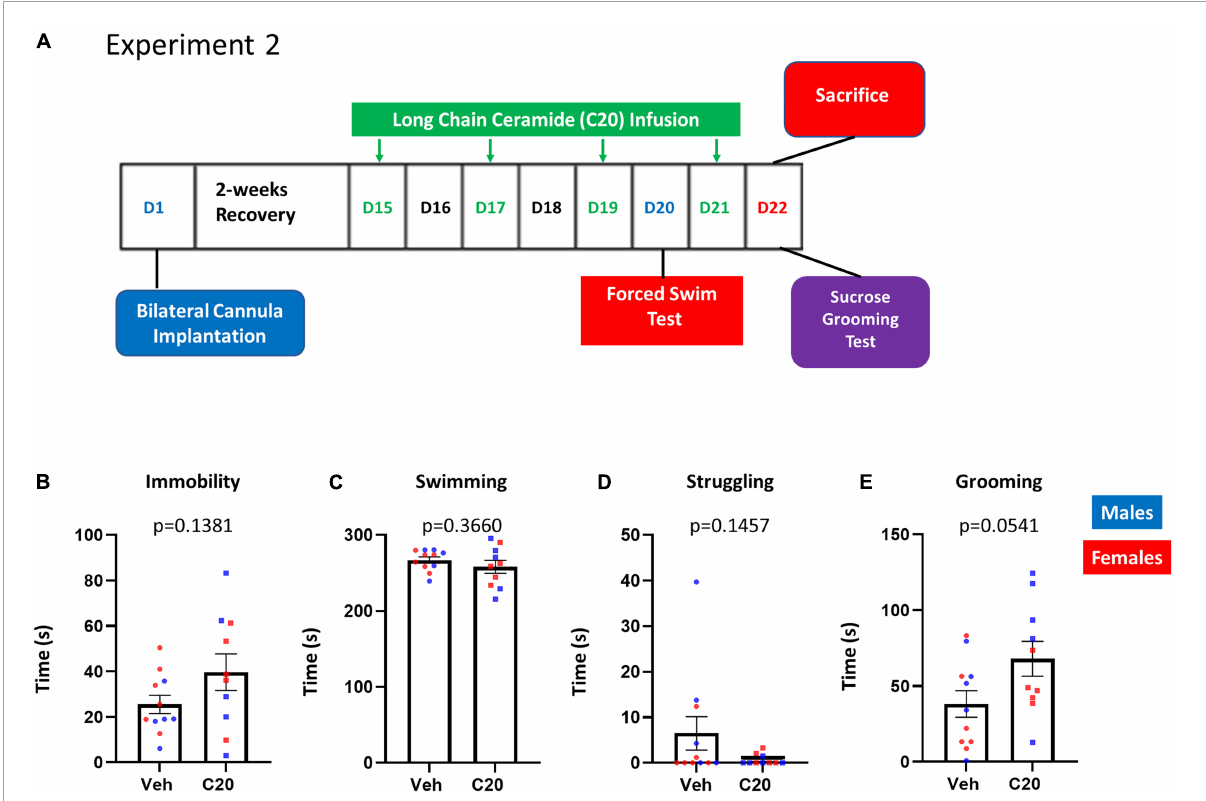
FIGURE2 Effects of C20:0 ceramide infusions on despair-like and sucrose grooming behavior. (A) Timeline of the bilateral cannula implantation surgery, 4–C20:0 ceramide infusions every 48 h (green font), forced swim test 24 h after the third infusion of C20:0 ceramides (blue font), and sucrose grooming test and sacrifice after the fourth infusion of C20:0 ceramides (red font). D = day as indicated in the experimental timeline. (B–D) Immobility, swimming, and struggling time measured during 5 min in the forced swim test to assess despair-like behavior on day 20. (E) Sucrose grooming time during 5 min as an assessment of apathy-like behavior on day 22 prior to sacrifice. N = 11 in vehicle group and n = 10 in ceramide infused groups. Males in blue symbols and females in red